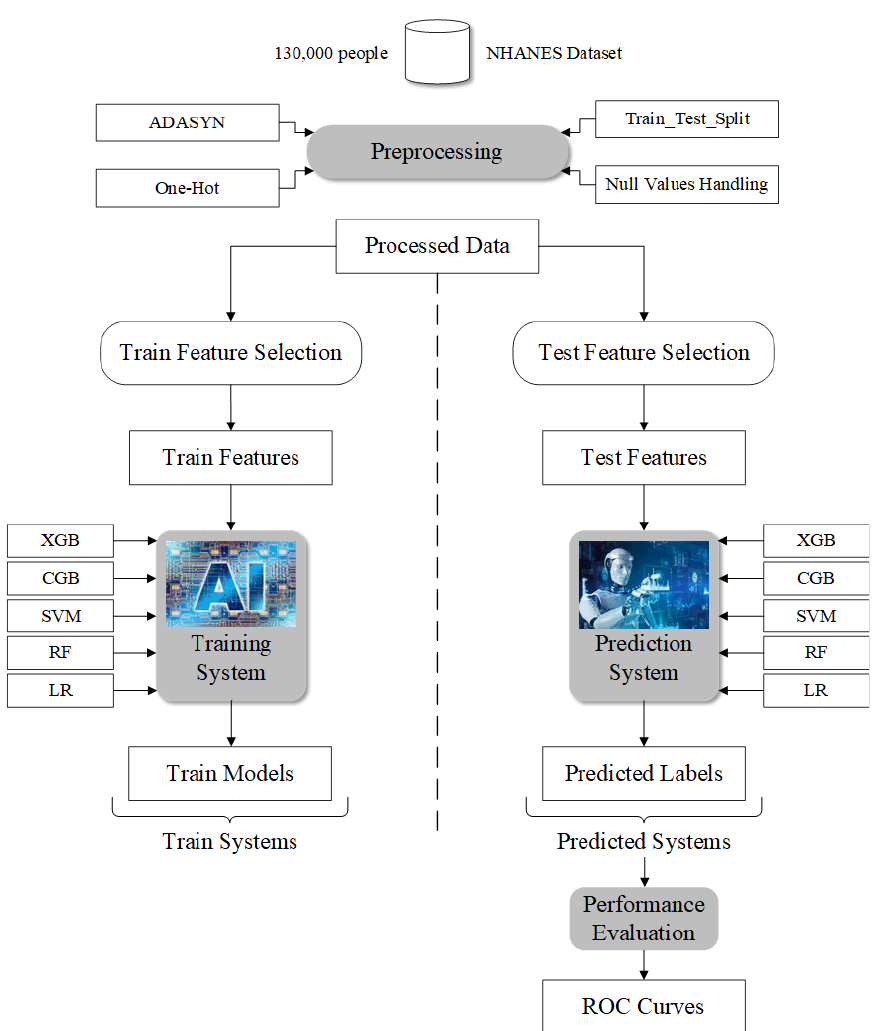
Figure 1. Data curation and machine learning process